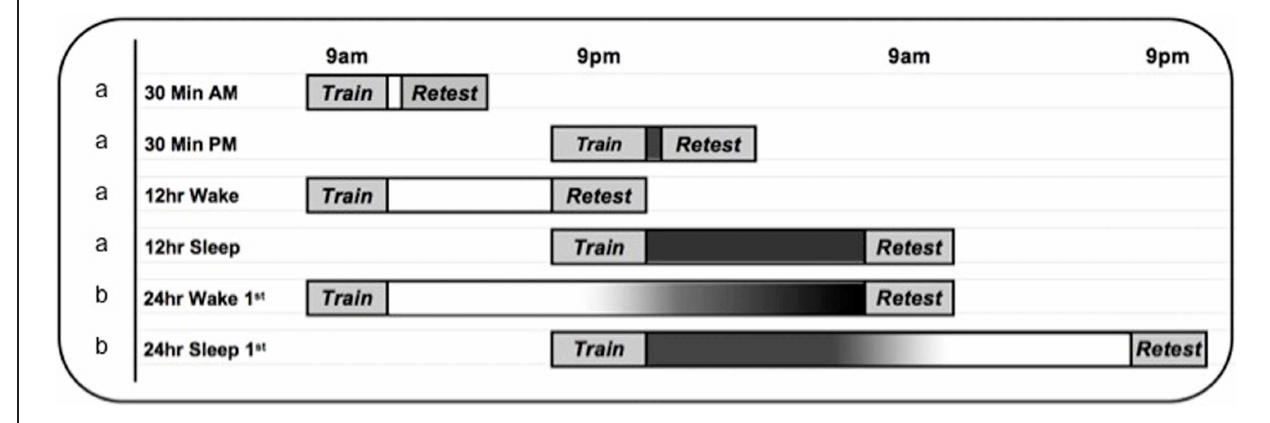
overnight polysomnography study reported here (Experiment 1, n = 27) follows the 12h Sleep protocol (labeled “a”), with the addition of overnight sleep monitoring in the laboratory. The 24h delay study (Experiment 2, labeled “b”) follows the 24h Wake 1st ( n = 22) and 24h Sleep 1st ( n = 22) protocols.